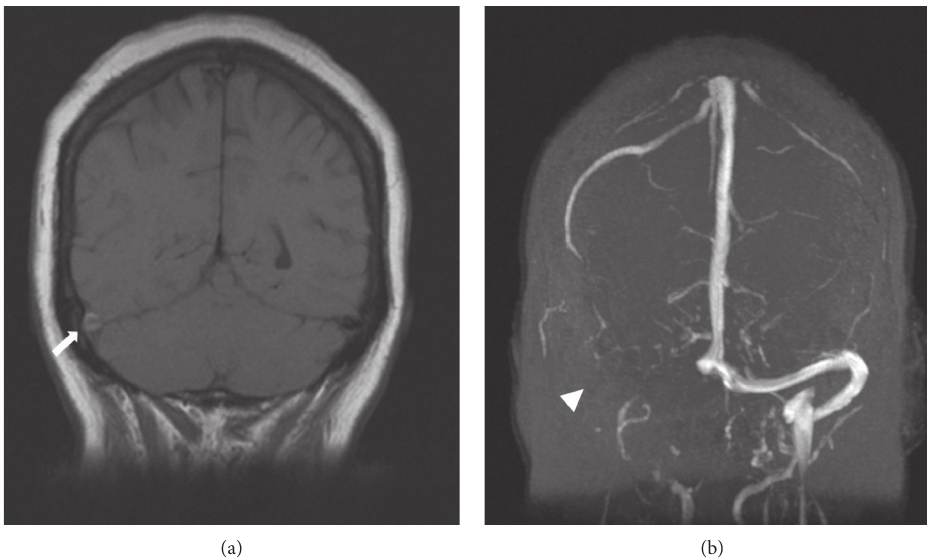
Figure 1: Magnetic resonance imaging demonstrating flow void at right transverse sinus (arrow) and absence of contrast (arrowhead) along transverse sinus consistent with transverse sinus